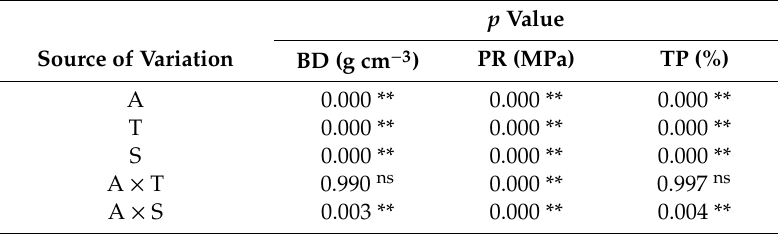
Table 3. Two-way ANOVA results for the e ff ects of tra ffi c intensity (T), slope gradient (S) and skid trail ages or recovery period (A) on soil bulk density (BD), penetration resistance (PR), and total porosity (TP). p Value Source of Variation BD (g cm − 3 ) PR (MPa) TP (%) A 0.000 ** 0.000